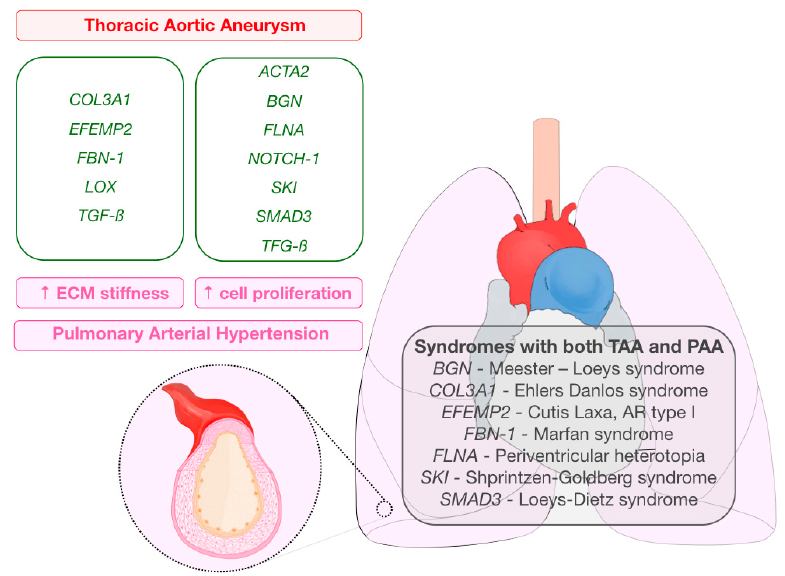
Figure 1. Graphical abstract representing genes related to thoracic aortic aneurysms that also encode for proteins implicated in the pathogenesis of pulmonary arterial hypertension (extracellular matrix stiffness (left column), increased cell proliferation (right column)). Syndromes in which pulmonary and aortic aneurysms may be present are also listed.